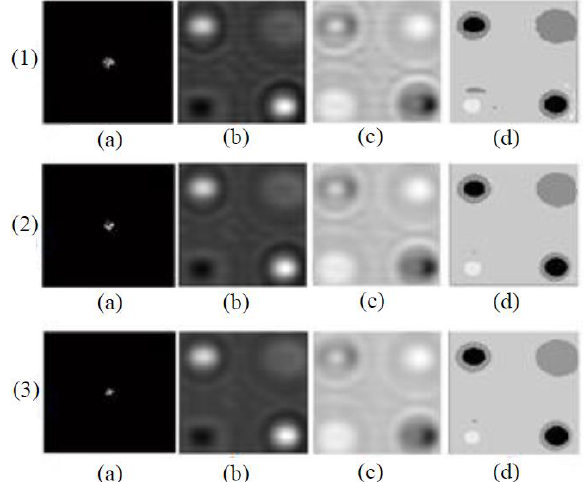
Figure 14. The total process of target segmentation of sample using Fourier transform and Gaussian followed by Multi-thresholding and erosion, with (1) single-, (2) two-fold, and (3) three-fold multiplications, ( a ) Fourier transforms, ( b ) inverted Fourier transforms (magnitude), ( c ) inverted Fourier transforms (phase), and ( d ) segmented results.